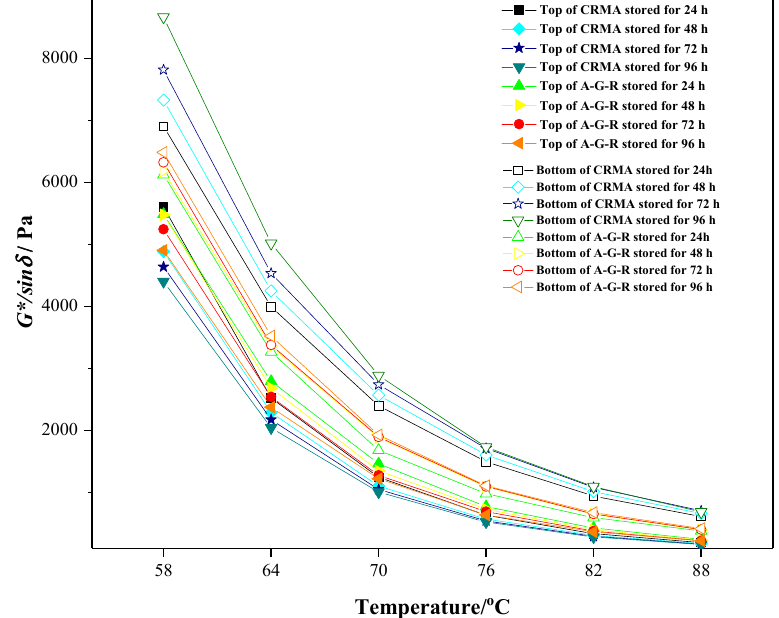
Figure 9. Rutting factor–temperature curve of CRMA and A-G-R.